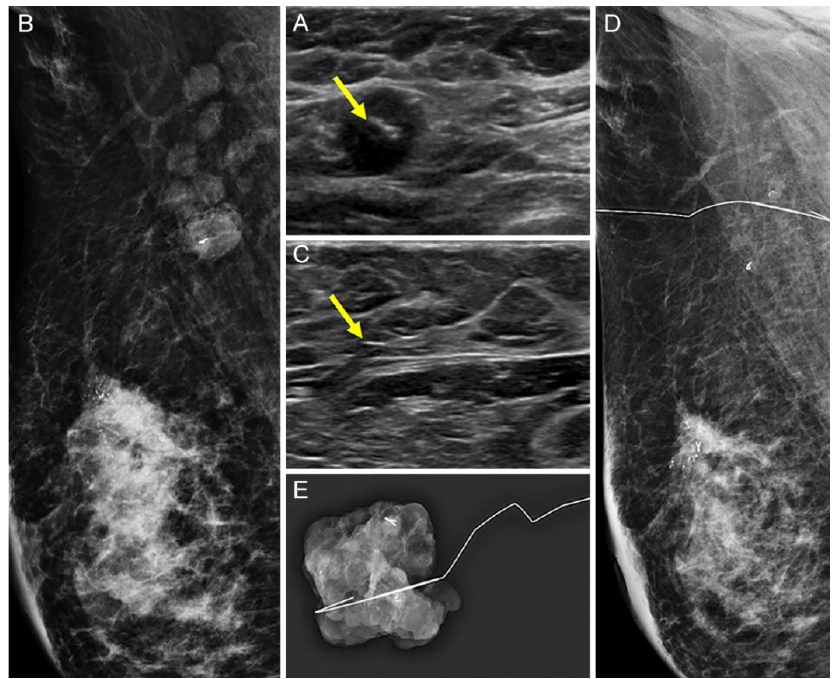
Figure 4. A 30-year-old woman with right breast cancer and ipsilateral axillary metastatic lymph node (LN) underwent UltraClip insertion prior to neoadjuvant chemotherapy (NAC). ( A , B ): The clip (arrow) was deployed at the cortex of the histologically proven metastatic LN by US ( A ) and the location was confirmed by mammography ( B ). ( C – E ): After NAC, no residual suspicious lymph node was detected on US and the clip location was not clear. An echogenic linear structure, suggest- ing the presence of the metal clip (arrow), was found at the presumed area of the previously clipped LN. A US-guided wire localization for the echogenic line considered a clip was performed ( C ): On mammography, however, the wire was not correctly located at the clipped LN ( D ). Subsequent specimen mammography confirmed the successful retrieval of the clipped LN ( E ).